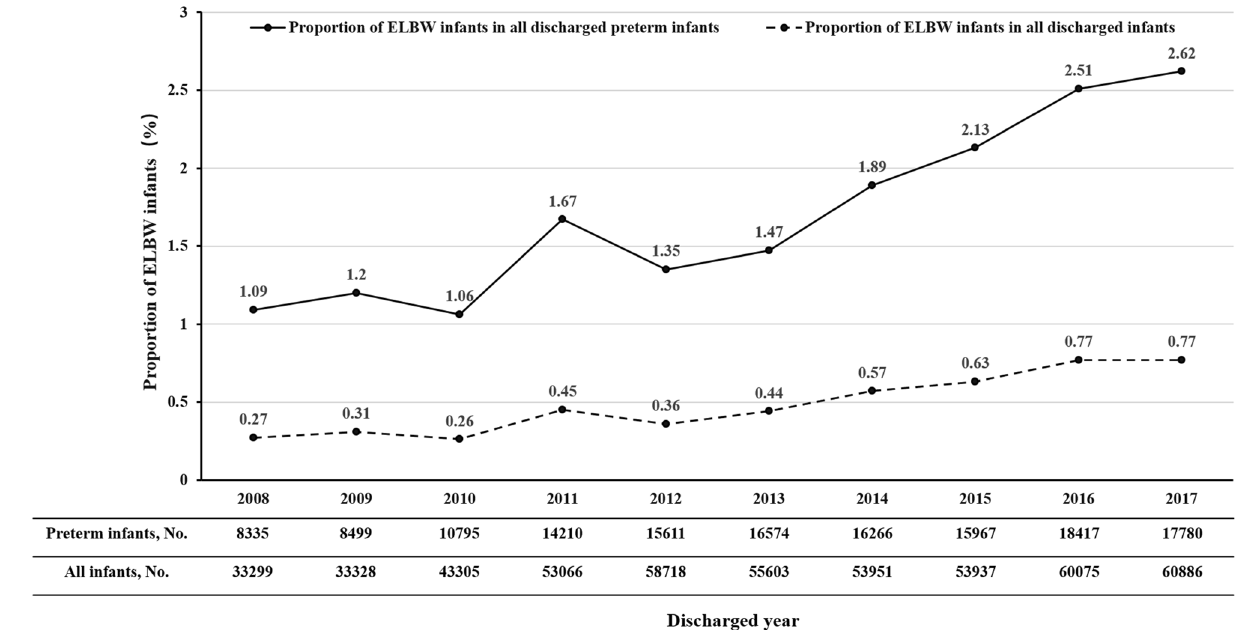
Figure 2. The proportion of ELBW infants in all discharged preterm infants or in all discharged infants from 2008 to 2017. The chi square test linear-by-linear association showed that the proportions of ELBW infants in all discharged preterm infants or in all discharged infants increased annually (both P <